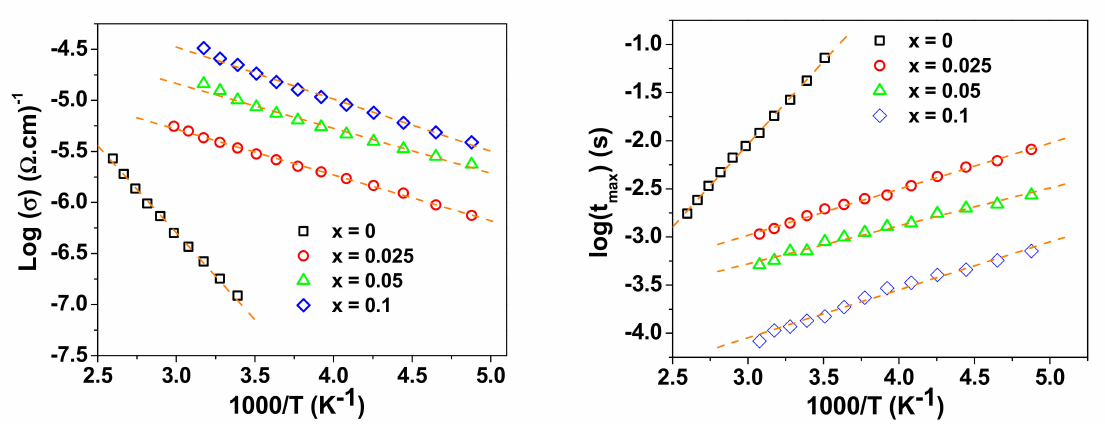
Figure 7. The Arrhenius plots of the conductivity σ ( left ) and relaxation time τ ( right ) in the grain- boundaries for NSTO ceramics. The dashed line represents the line of best fit.